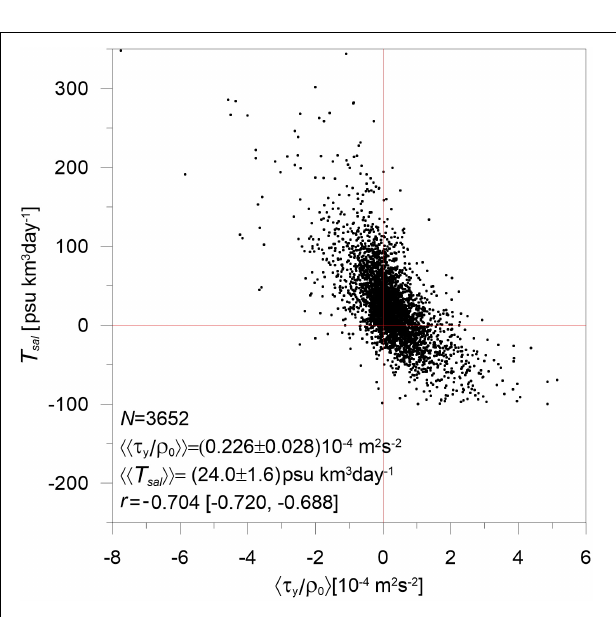
FIGURE 4 | A scatter plot of the daily saltwater transport T sal through cross-section S1 vs. the daily mean of the y -component of wind stress (cid:104) τ y / ρ 0 (cid:105) ; (cid:104)(cid:104) ... (cid:105)(cid:105) is the 10-year mean value. The numbers in the square brackets and next to the ± sign quantify the 95% confidence limits.